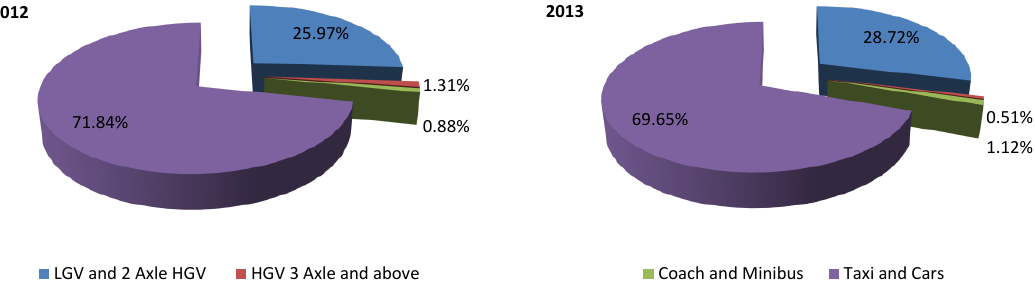
Figure 2. Traffic vehicle type compositions from four sites traffic count points in 2012 and 2013 The volume of freight vehicles visiting the University was relatively high, at over 25% of traffic recorded in 2012 and over 29% in 2013. In addition, there is an observed and persistent level of illegal parking along the external periphery of the site, largely couriers, but also by catering supplies vehicles. These percentages are almost double the average urban freight activity which, according to existing literature, is between 10% and 18% (European Commission, 2006; Woudsma, 2001). Despite the high percentage of freight visits to the University premises, the volume of freight traffic (LGV and 2 axle HGV) reduced by 4% from 2012 to 2013. Further investigation of all traffic entering and exiting the University premises demonstrated steady flows of traffic, with morning and afternoon peaks as can be seen in Figure 3 and Figure 4. Wednesday was chosen as a relatively busier day for freight traffic (Zunder et al., 2012).